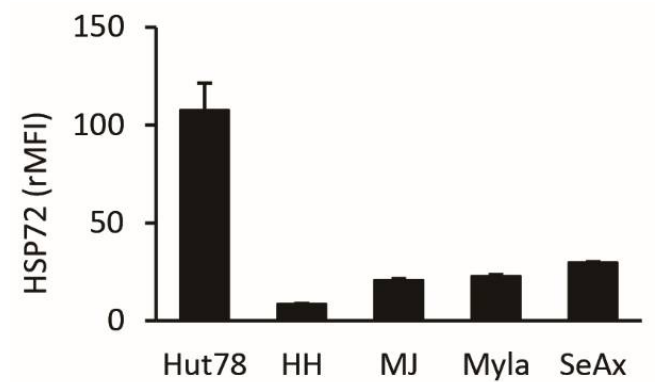
Figure 1. Expression of HSP72 protein in five cutaneous T-cell lymphoma (CTCL) cell lines. Expres- sion of HSP72 in each cell line was described as the relative mean fluorescence intensity (rMFI) + SD (n = 3).